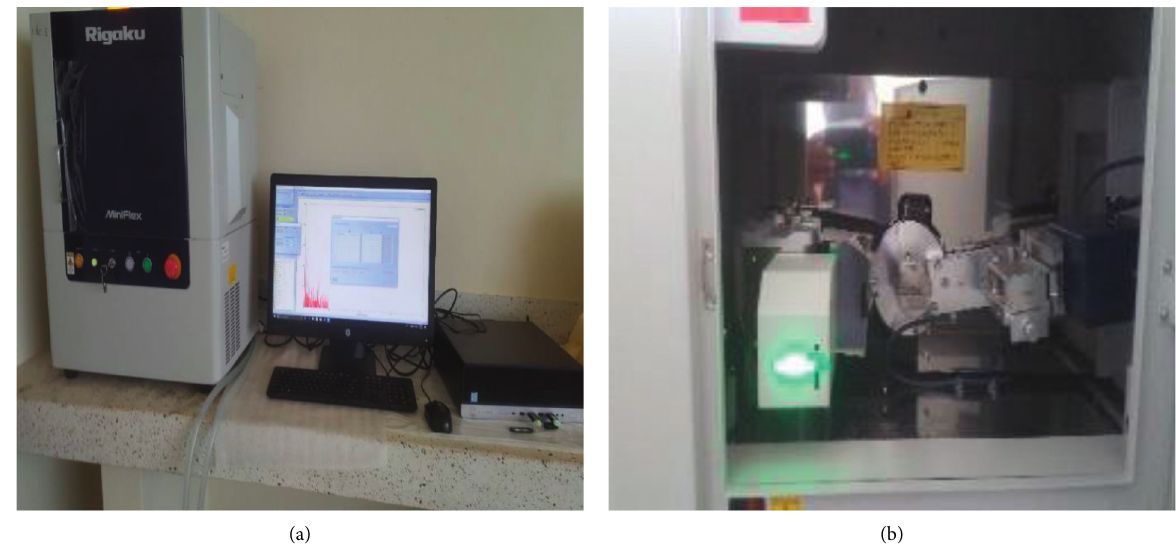
Figure 8: Energy dispersive X-ray spectroscopy